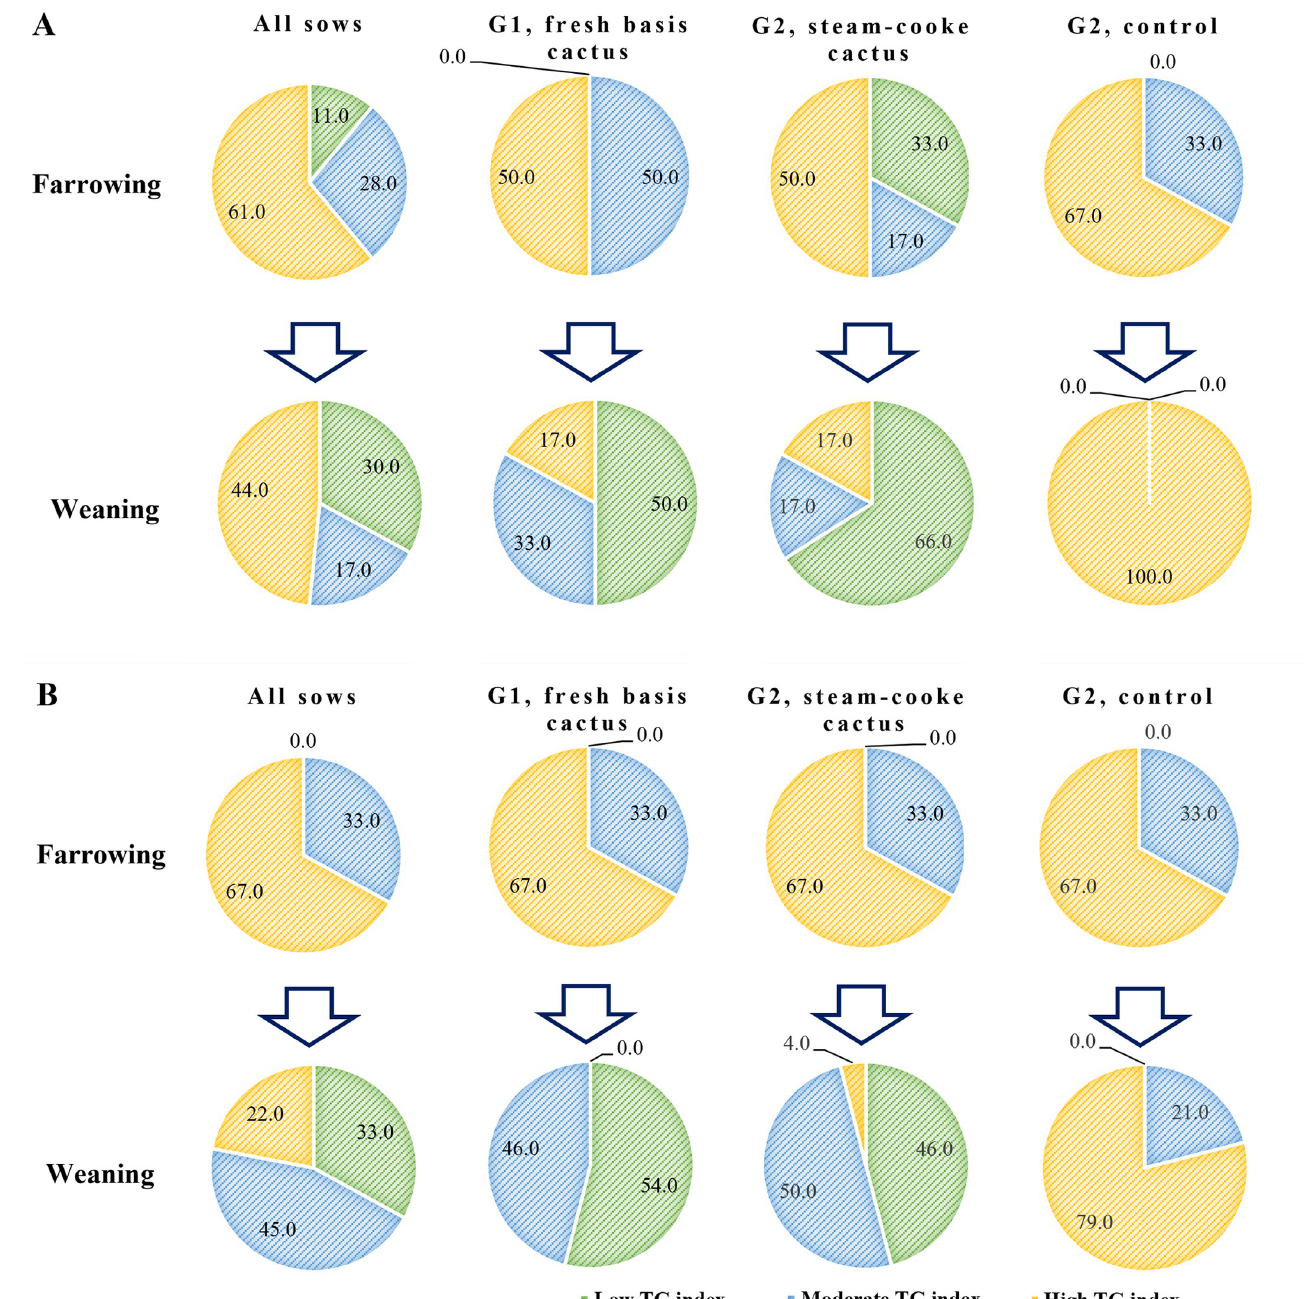
Fig 3. Proportion of sows with glucose intolerance according to the classification of the triglyceride and glucose index calculated using glycemia from the HGI (A) and blood glucose concentrations measured by the glucometer (B) per group and reproductive phase.